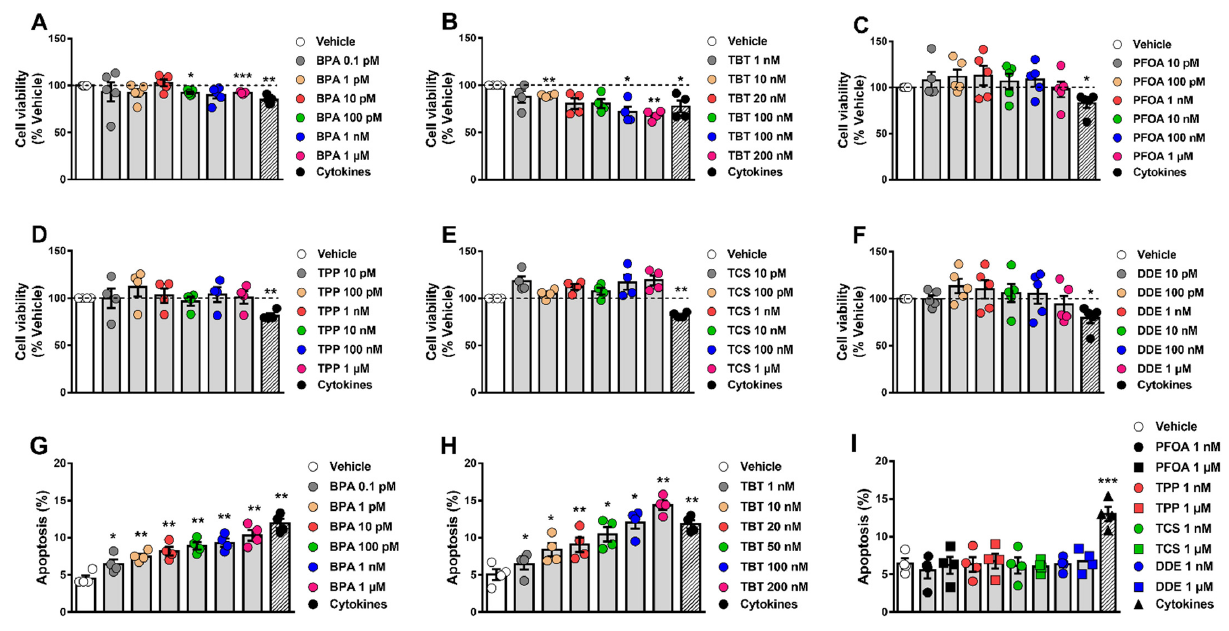
Figure 1. α -cell viability upon MDC exposure. ( A – F ) α TC1-9 cells were treated with vehicle (DMSO) or different doses of BPA ( A ), TBT ( B ), PFOA ( C ), TPP ( D ), TCS ( E ), or DDE ( F ) for 48 h. A cocktail of the cytokines IL-1 β + IFN γ (50 and 1000 U/mL, respectively) was used as a positive control. Cell viability was evaluated by MTT assay. ( G – I ) α TC1-9 cells were treated with vehicle (DMSO) or different doses of BPA ( G ), TBT ( H ), PFOA, TPP, TCS, or DDE ( I ) for 24 h. Apoptosis was evaluated using HO and PI staining. Data are shown as means ± SEM (n = 4–5 independent experiments, where each dot represents an independent experiment). * p ≤ 0.05, ** p ≤ 0.01 and *** p ≤ 0.001 vs. Vehicle. MDCs vs. Vehicle by one-way ANOVA; Cytokines vs. Vehicle by two-tailed Student’s t test.